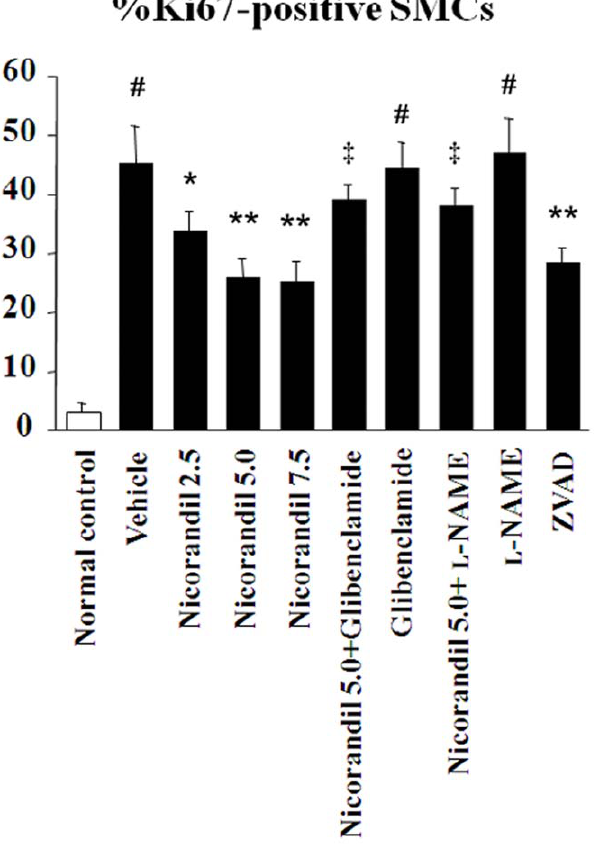
Figure 3. Nidorandil attenuates proliferation of PA-SMCs in MCT-injured lungs. Immunofluorescent double staining of lung frozen sections for Ki67 and a SMA was performed. The number of proliferating PA-SMCs with Ki67 positive nuclei expressed as the percentage of Ki67-positive cells over the total number of a SMA- positive SMCs in the media of 30–40 PAs (external diameter, 20– 100 m m) per rat was significantly reduced by treatment with nicorandil and ZVAD-fmk. In contrast, glibenclamide and L -NAME diminished the effect of nicorandil, respectively. # P , 0.01 vs. normal control; * P , 0.05 and ** P , 0.01 vs. vehicle; { P , 0.01 vs. nicorandil (5.0 mg ? kg 2 1 ? day 2 1